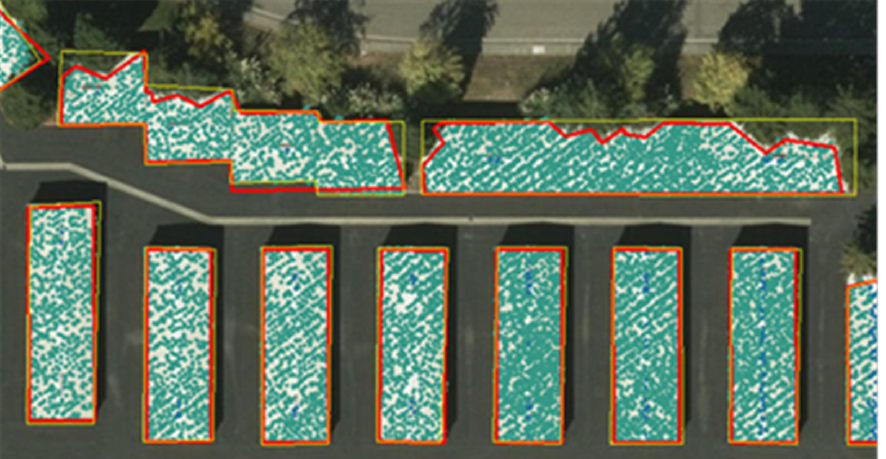
Figure 18. Example of Vegetation occlusion in Santa Rosa dataset.